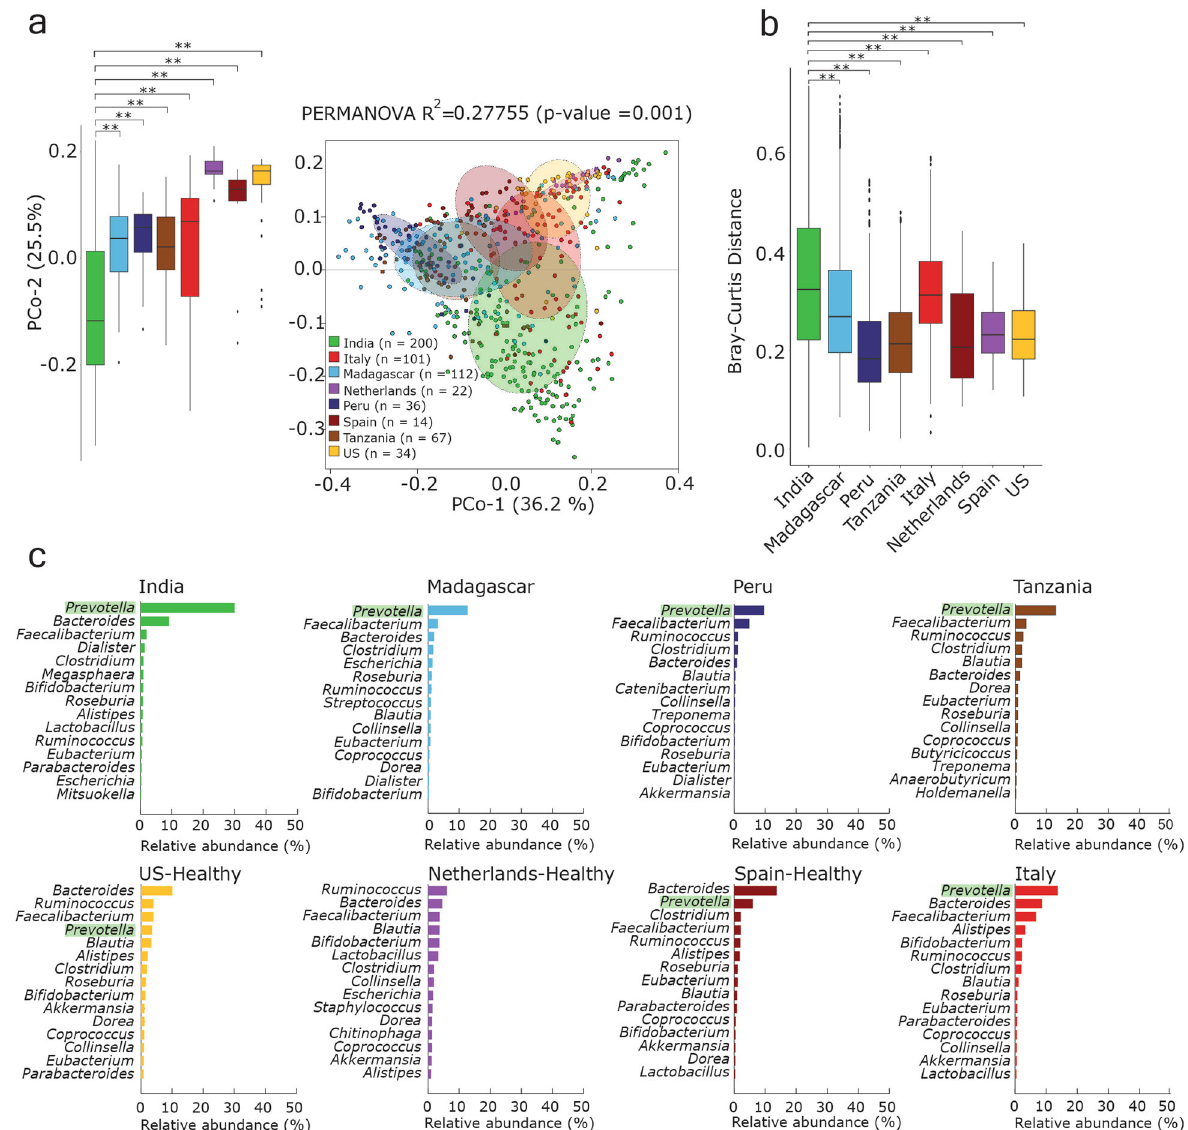
Fig. 1 Prevotella is the most abundant genus in the distinct Indian gut microbiome. a Principal coordinates analysis considering inter- sample Bray – Curtis distance based on species abundance table (obtained from classi fi cation of reads using Kaiju). Total number of samples in each data set is given in the left bottom. b Box-plot showing inter-sample variation based on the abundance of different bacterial species in each sample (using pairwise Bray – Curtis distance) in each population. c Relative abundance of top 15 genera in each healthy population. Relative abundance was calculated after classifying reads at the genus level using Kaiju. Prevotella genus is highlighted in a lighter shade of green color. The whiskers, bound of the box, and the line in the middle of the box represent the min-to-max values, 25th – 75th percentiles, and median, respectively. Kruskal – Wallis test was used to test the distributions of box plots. ns refers to “ not signi fi cant ” , and ** indicates p - value < Figs. 7 – 10, and Supplementary Data 7). 102 Prevotella genomes/